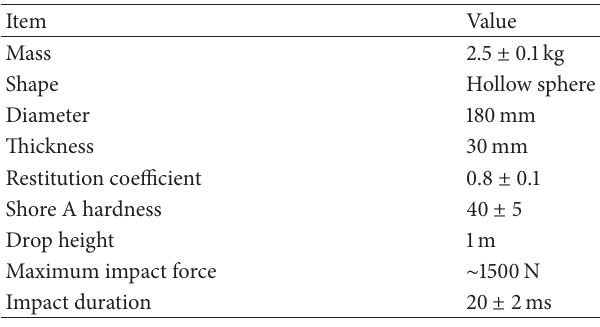
Table 1: The specific of standard heavy impact source of rubber ball [20].